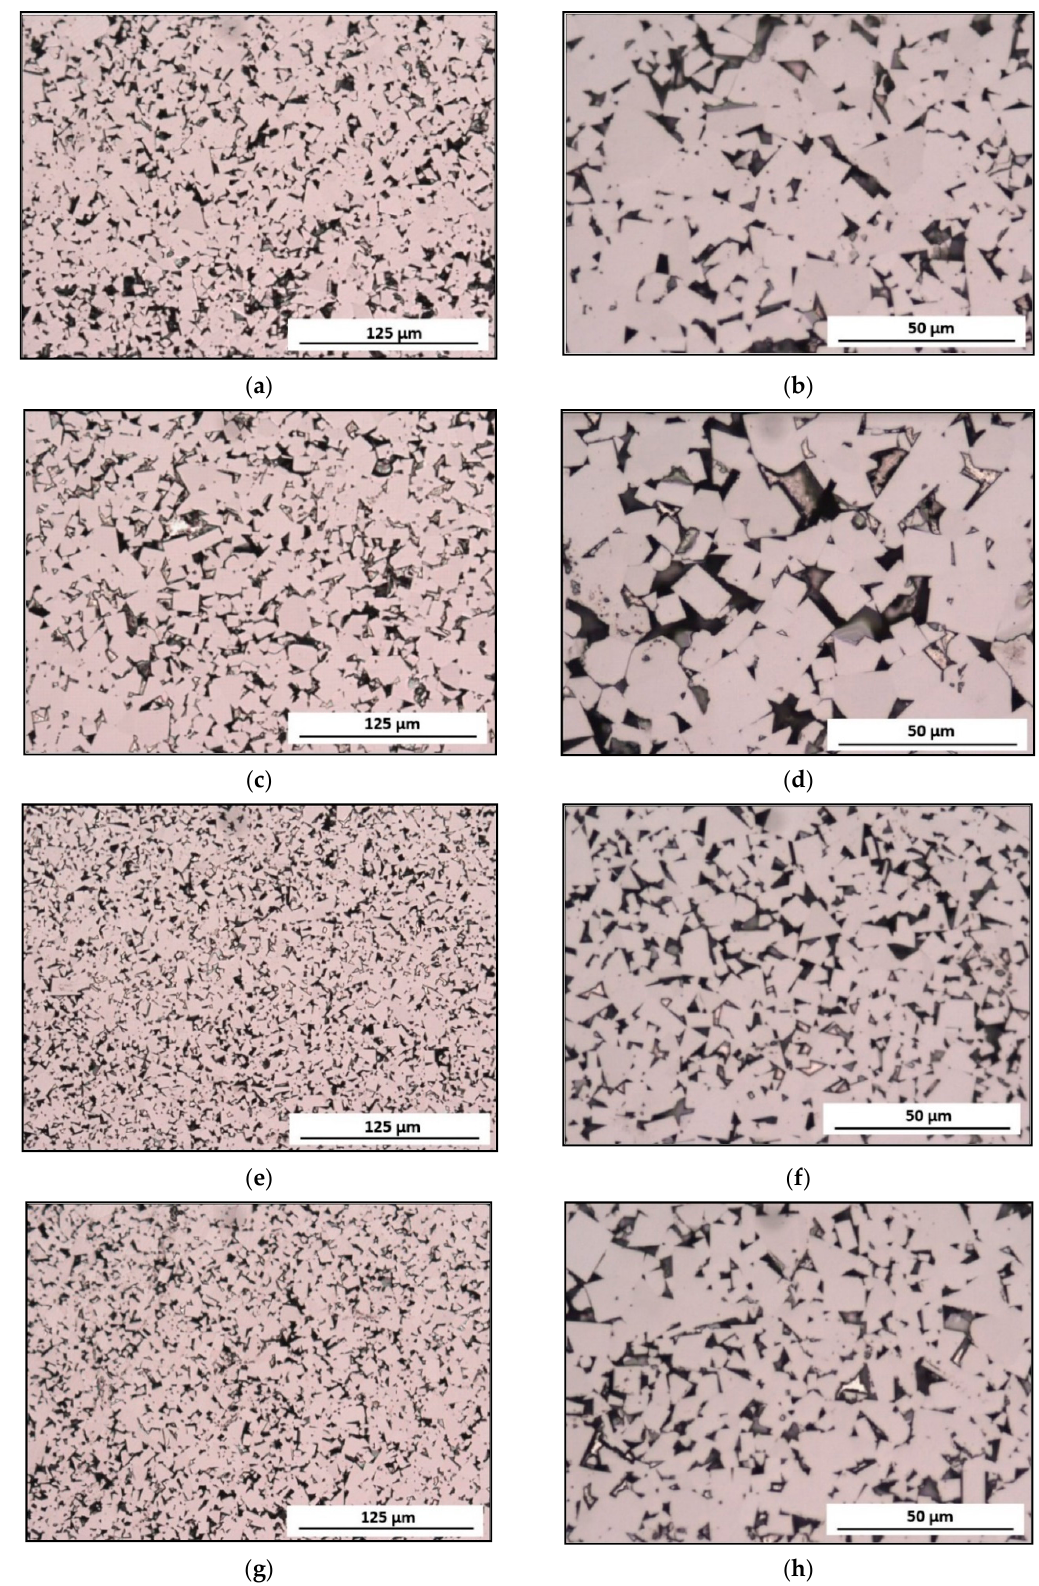
Figure 4. Microstructures of the examined tips made of sintered tungsten carbide–cobalt (WC-Co): ( a , b ) Longwall 1 tip, ( c , d ) Road 1 tip, ( e , f ) Longwall 2 tip, ( g , h ) Road 2 tip. Light Microscope (LM), Bright Field (BF).